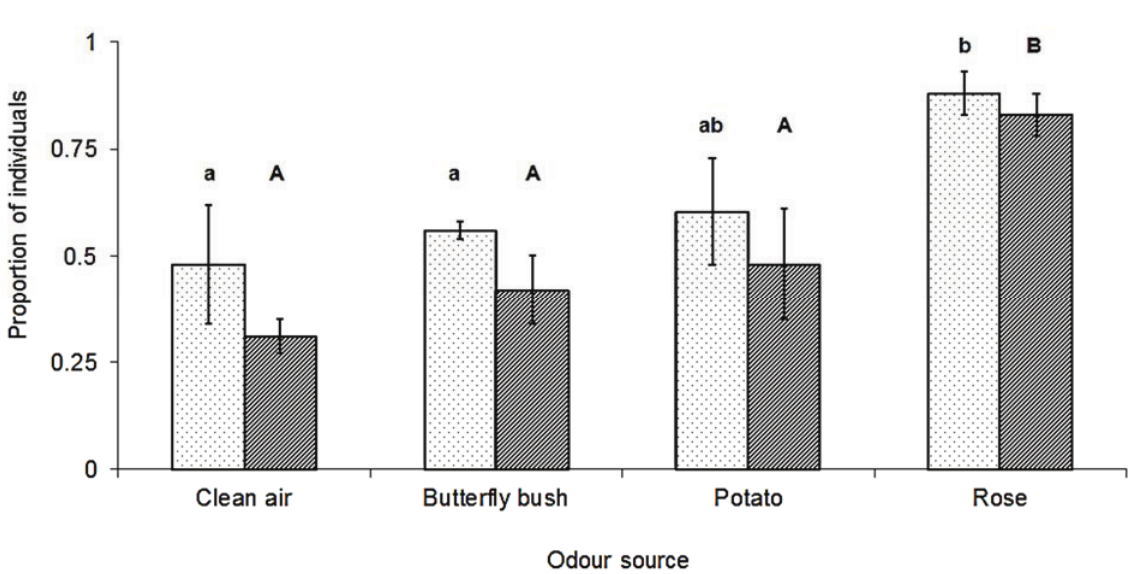
Figure 1. Proportion (X ± SEM) of M. euphorbiae gynoparae (N = 48 in each treatment) that oriented towards (dotted bars) or reached (striped bars) the different odour sources in wind tunnel assays. Columns with different letters, either for orienting to or reaching the source, are significantly different (Tukey’s HSD, p <